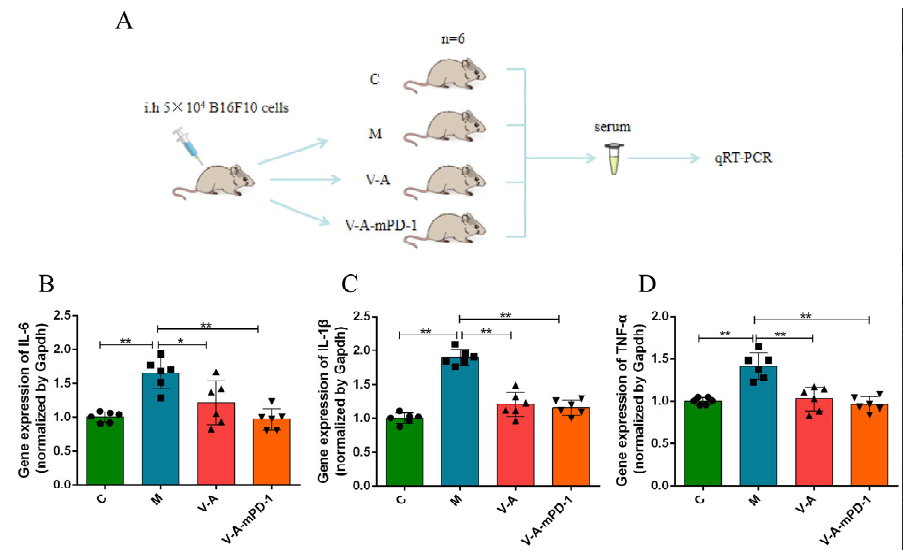
Figure 5. V-A-mPD-1 has the potential to reduce systemic inflammation in melanoma mice. ( A ) The experimental scheme of q-PCR. ( B – D ) Pro-inflammatory cytokines IL-6, IL-1 β , and TNF- α were detected in serum at the gene level by q-PCR. C, The normal control group; M, the melanoma model group; V-A, the V-A treatment group; V-A-mPD-1, the V-A-mPD-1 treatment group. One-way ANOVA and Tukey’s multiple comparison for B–D. Data are presented as means ± SD ( n = 6). * p < 0.05, ** p < 0.01.